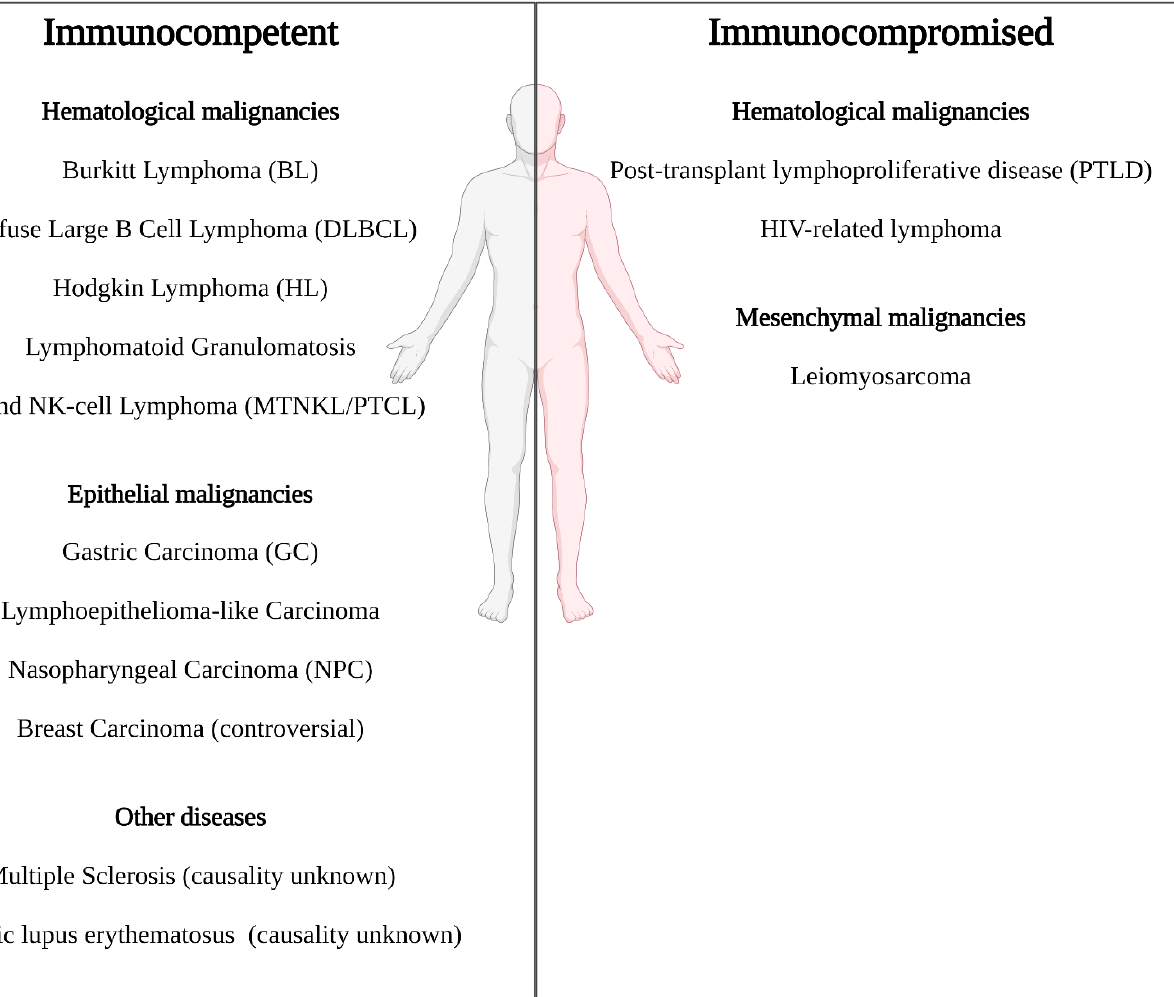
Figure 1. EBV-associated diseases in immunocompetent ( left ) and immunocompromised ( right ) patients. Details are provided in Table 1. Created with BioRender.com.